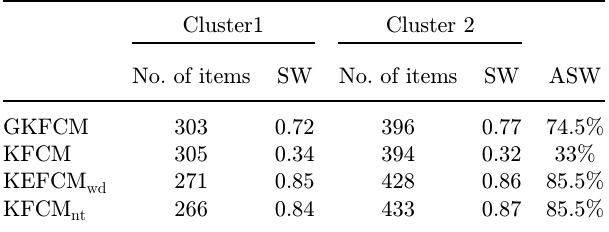
Table 6. Silhouette average values in clustering Breast cancer Data. Cluster1 Cluster 2 No. of items SW No. of items SW ASW